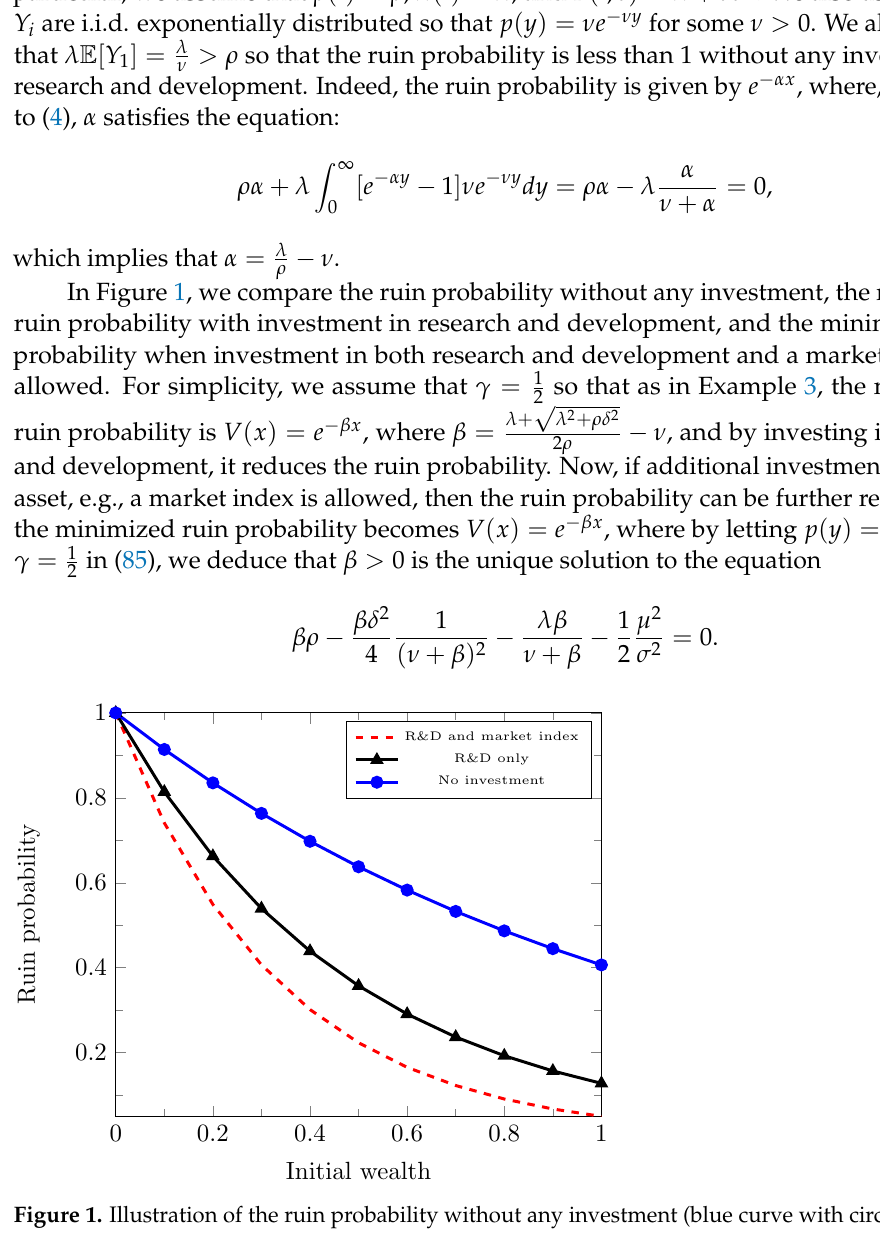
Figure 1. Illustration of the ruin probability without any investment (blue curve with circle markers), the minimized ruin probability with investment in research and development (black curve with triangle markers), and the minimized ruin probability when investment in both research and devel- opment and a market index are allowed (red dashed curve). The x -axis denotes the initial wealth of the underlying company and the y -axis denotes the (minimized) ruin probability. Here, we take γ = 1 , ρ = 0.1, ν = 0.1, λ = 0.1, δ = 1, µ = 0.1 and σ = 2